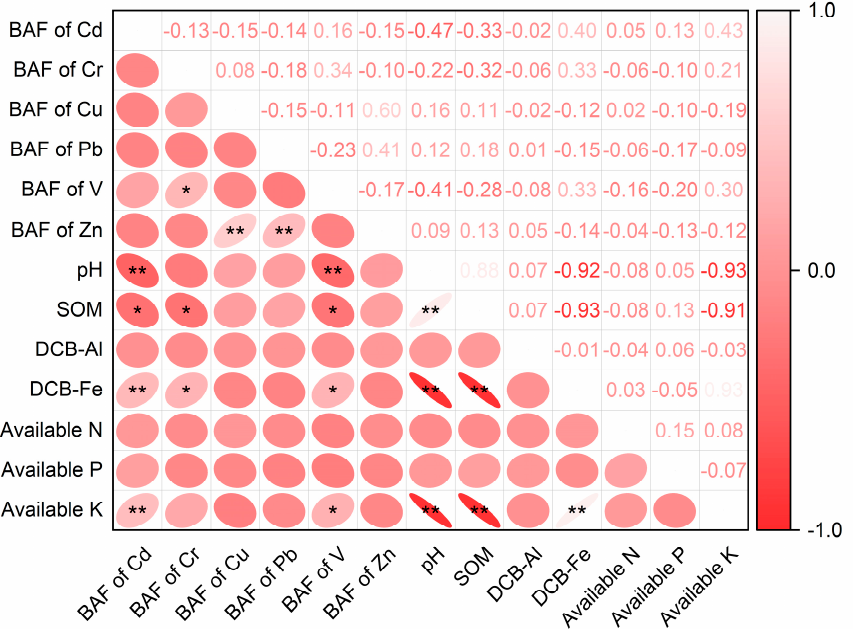
Figure 6. The correlation coefficient matrix of bioaccumulation factor (BAF) of trace metals and soil properties. *, p < 0.05. **, p < 0.01. properties. *, p < 0.05. **, p <